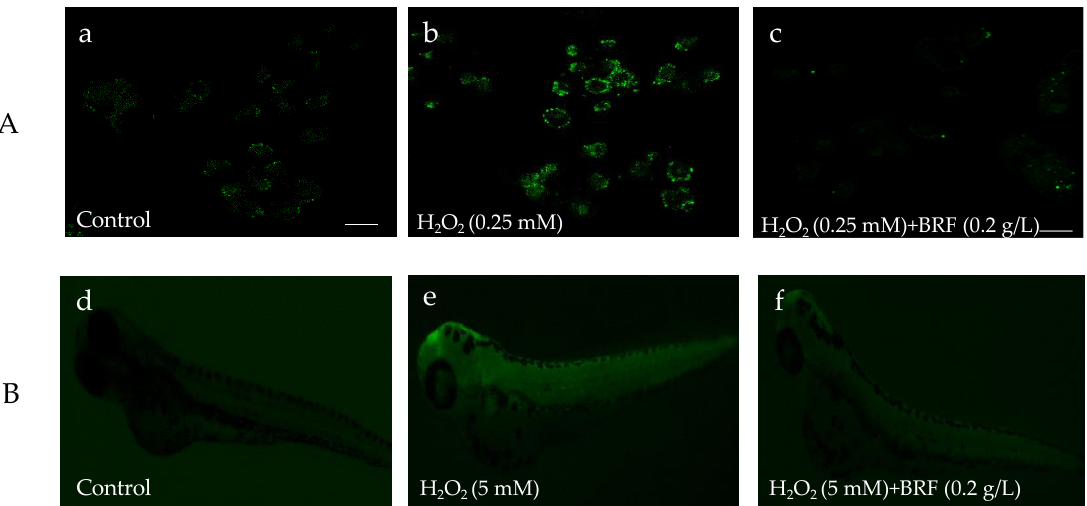
Figure 7. The antioxidant effect of BRF on H 2 O 2 -induced reactive oxygen species (ROS) production in zebrafish embryos. ( A ) L02 cell under fluorescence microscope; ( B ) zebrafish embryo under fluorescence microscope.